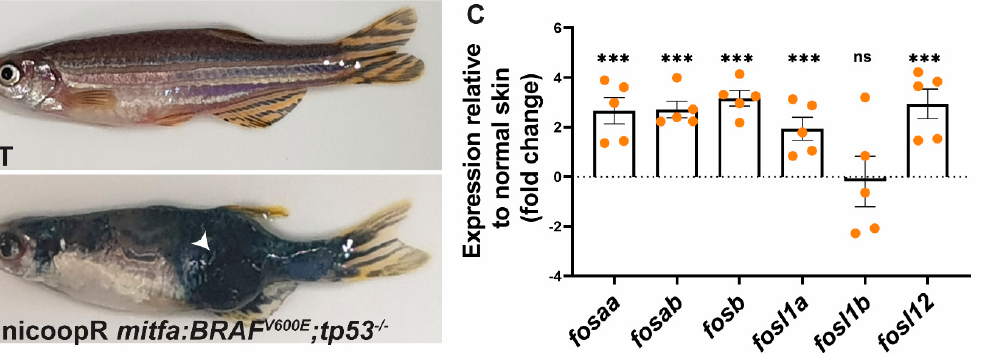
Figure 7. Relative expression of fos genes in human BRAF V600E oncogene driven melanoma in zebrafish. mRNA expression levels of zebrafish fos genes were determined in normal wildtype (WT) skin ( A ) and melanoma tumour from BRAF V600E ; tp53 -/- zebrafish line ( B ), with the graph showing the expression relative to the normal skin (fold change) ( C ). The relative mRNA levels were normalised to actb and ddct values determined by comparison with expression in the normal wildtype skin. Error bars indicate the standard error of mean for five biological replicates with statistical signifi- cance indicated (***p<0.001, ns not significant). The white arrow indicates the tumour.